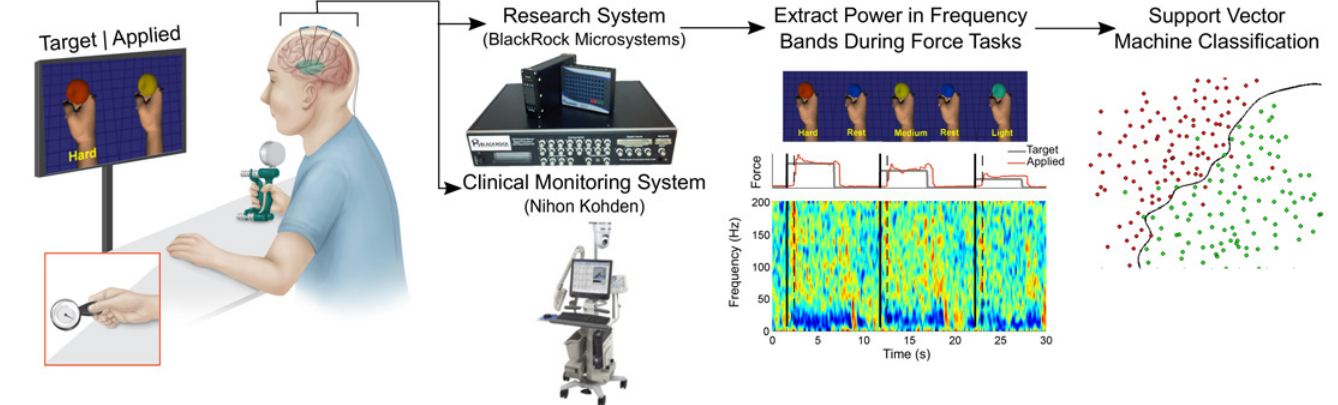
Fig 1. Experimental Setup. Participants had stereotactic depth electrodes placed for clinical epilepsy monitoring and were asked to perform force matching tasks in two different grasp configurations (power grasp and lateral pinch grasp – inset). Participants were prompted by a screen showing them the desired force level as well as their delivered level of force each represented as the color and size of a ball being squeezed on the screen. SEEG signals were split between the clinical monitoring system and the research neural recording system. Frequency band powers were calculated offline with a short-time-Fourier transform and used for discrete state